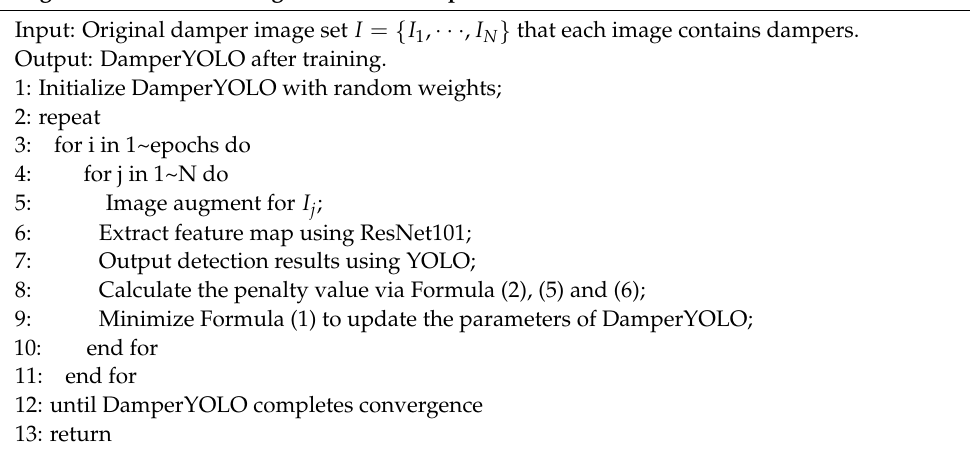
Figure 4. The realization of detection of vibration dampers is divided into three parts: Edge Detection, Feature Extraction, Feature Fusion. First, Edge Detection is used to provide edge information. then Feature Extraction and Feature Fusion are used to obtain feature maps for vibration dampers. Finally, the detection results can be obtained from classifier of YOLOv4. Algorithm 1: The Training Process of